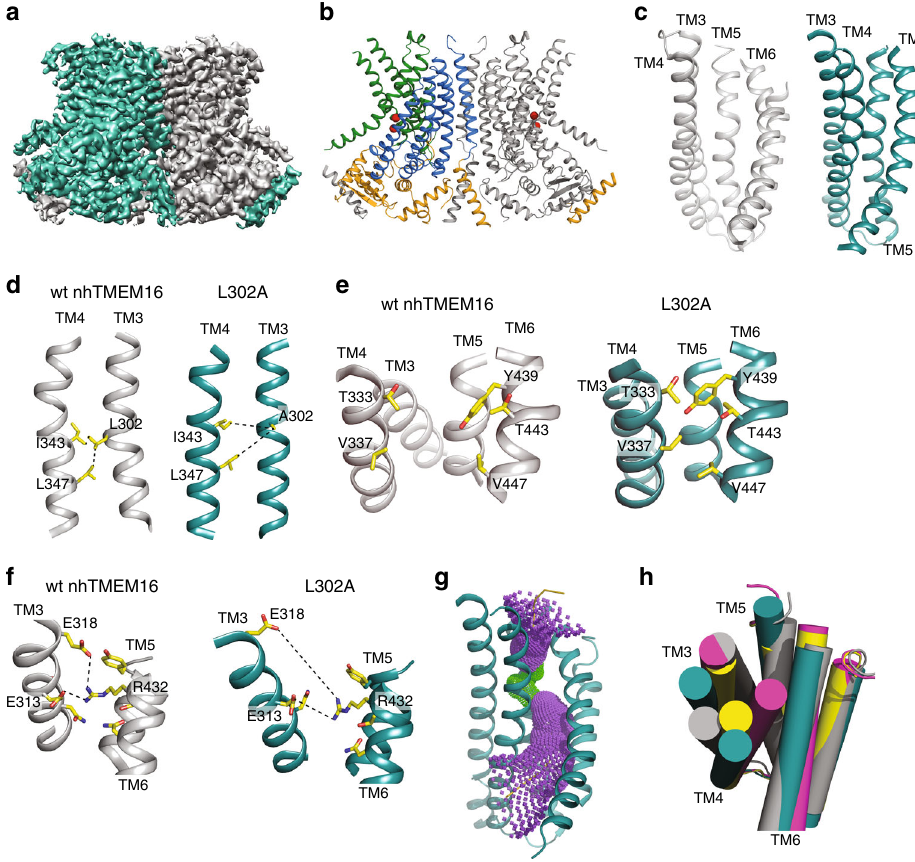
Fig. 7 Structure of nhTMEM16 L302A in lipid nanodiscs. a Masked cryo-EM density maps of L302A nhTMEM16 in the presence of 0.5 mM Ca 2 + . One monomer is shown in gray, the other is teal. b Atomic model of L302A nhTMEM16. One monomer is gray, in the other the cytosolic domain is orange, the permeation pathway is green, and the remainder of the protein is blue. Ca 2 + ions are shown as red spheres. c – f Structural comparison of the lipid pathway of wt (4WIS, left panels, gray) and L302A (right panels, teal) nhTMEM16. The color scheme is the same throughout the fi gure. c The lipid pathway (TM3- TM6) of the L302A mutant and WT (4WIS) viewed from the plane of the membrane. d – f Close up views of the structural rearrangements induced by the L302A mutation at the lipid pathway. The protein backbone is shown in ribbon representation and important residues are shown as sticks and colored in CPK yellow. d L302A disrupts the TM3/TM4 interface. Dashed lines indicate the distances between L302 on TM3 and I343/L347 on TM4. The distances respectively change from 3.7 to 7.4 Å and from 5 to 7.2 Å indicating that TM4 moves away from TM3. e Closure of the pathway to the membrane. The movement of TM4 towards TM6 enables the packing of the side chains of T333/V337 on TM4 and Y349/T443/V447 on TM6 to form a steric barrier to lipid entry. f Opening of the extracellular gate. The rearrangements induced by the L302A mutation cause the disengagement of E313 and E318 on TM3 from R432 on TM6. The R432-E313 distance increases from 4.9 Å (WT) to 8.9 Å (L302A) while the R432-E318 distance increases from 4.5 Å (WT) to 12.3 Å (L302A). g The diameter of the L302A groove was estimated using the HOLE program 50 . Purple denotes areas of diameter d > 5.5 Å and green areas where 2.75 < d < 5.5 Å. h Top view of the lipid pathway. TM3 – 6 are shown as cartoon helices. Gray: Ca 2 + -bound open nhTMEM16 (4WIS); pink: Ca 2 + -bound closed nhTMEM16 (6QMB); yellow: Ca 2 + -bound intermediate (6QMA); teal: L302A